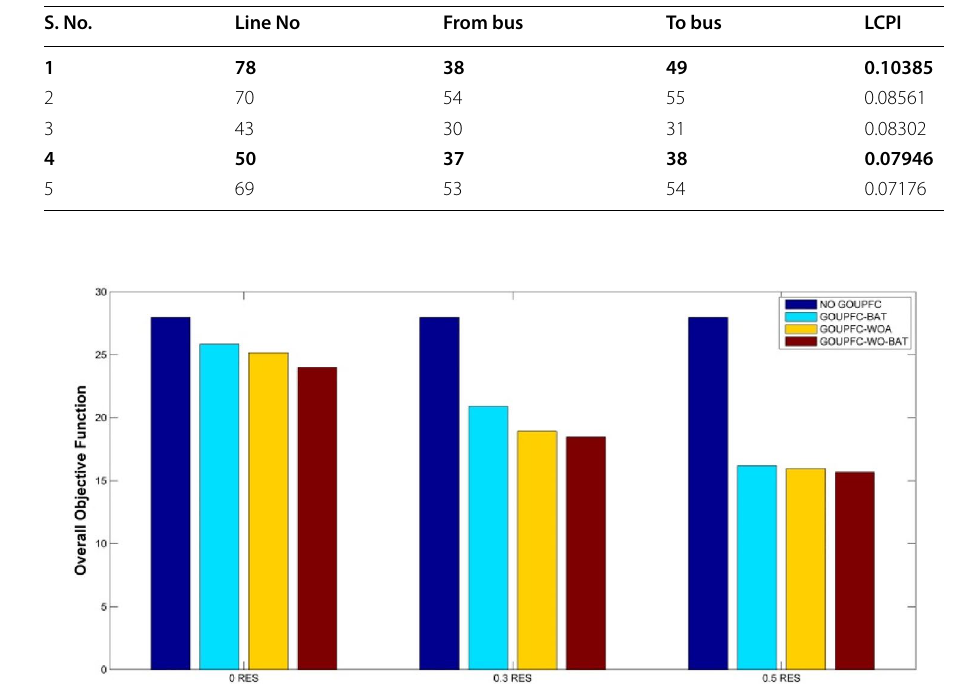
Fig. 6 GOUPFC under without contingency and at different RES penetration